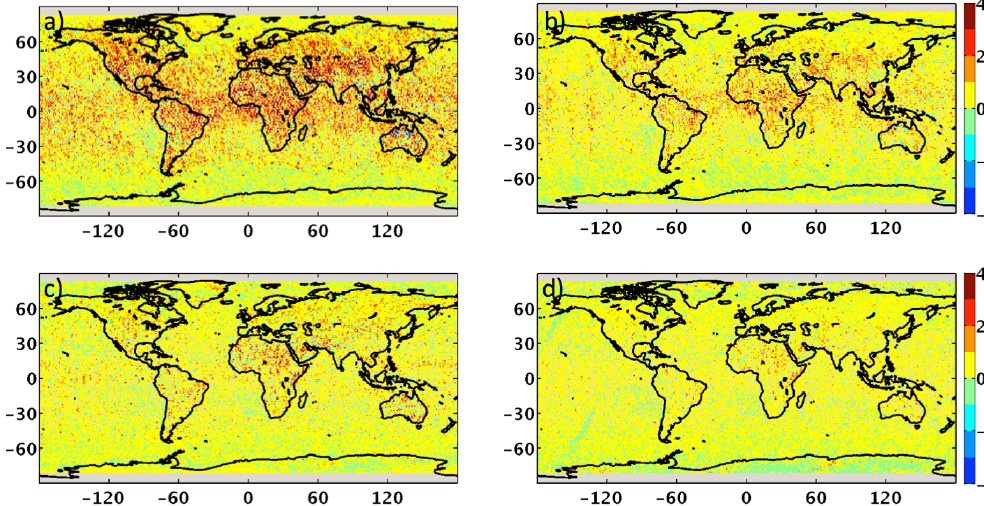
Figure 20. TOA LW flux error (Wm − 2 ) caused by scene identification uncertainty (standard – enhanced) (a) daytime LW flux error only using near-nadir viewing geometries, (b) daytime LW flux error using extended viewing geometries that are similar to the CERES observations, (c) same as (a) but for nighttime LW flux error, (d) same as (b) but for nighttime LW flux